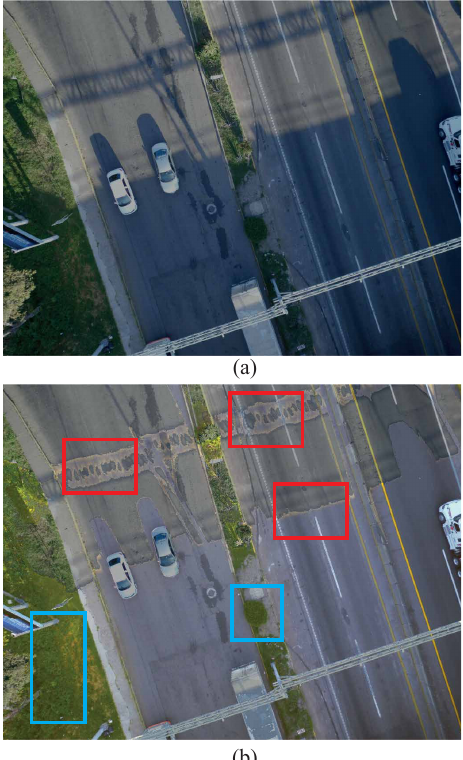
Figure 3. Input image ( a ) and the proposed color transfer result ( b ). Red rectangles focus on concrete areas and blue in vegetation or